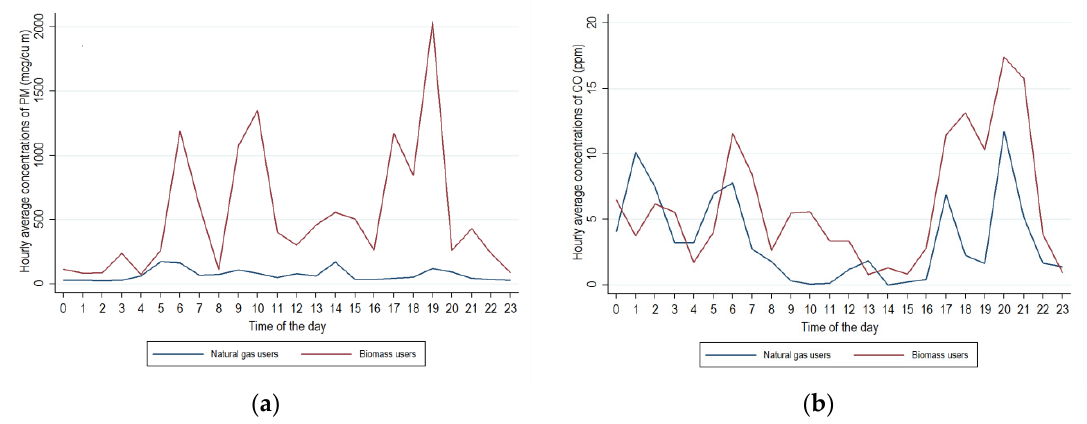
Figure 2. Arithmetic means across households of hourly average concentrations of ( a ) PM 2.5 (µg/m 3 ) and ( b ) CO (ppm) by time of day and type of fuel.